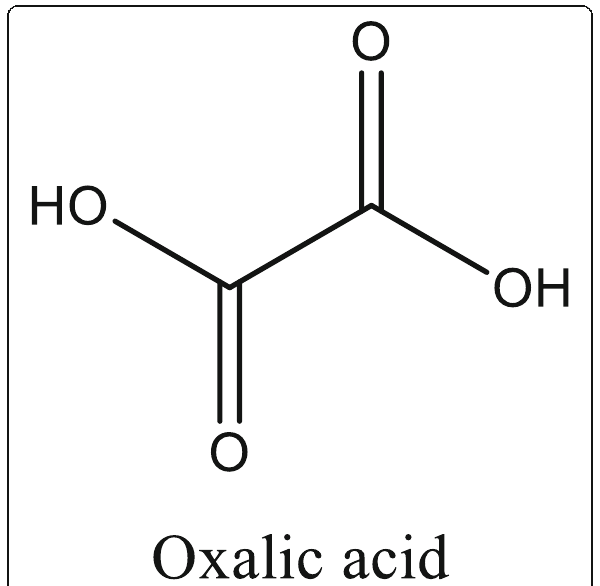
Fig. 12 Chemical structure of a dicarboxylic acid isolated from A.